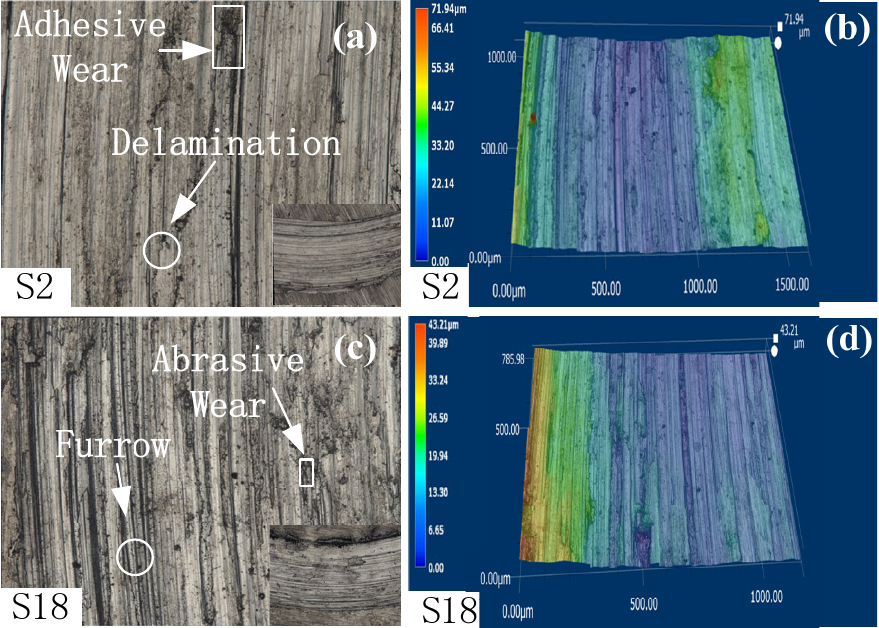
Figure 10. Wear surface of the test piece. ( a ) Local ‐ wear morphology of Specimen S2. ( b ) Three ‐ dimensional wear morphology of Specimen S2. ( c ) Local ‐ wear morphology of Specimen S18. ( d ) Three ‐ dimensional wear morphology of Specimen S18.